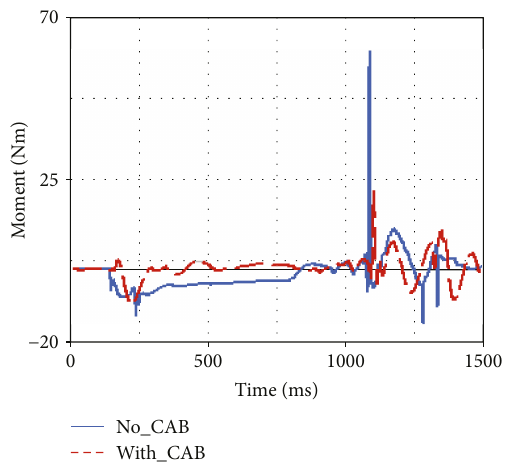
Figure 10: Upper neck M